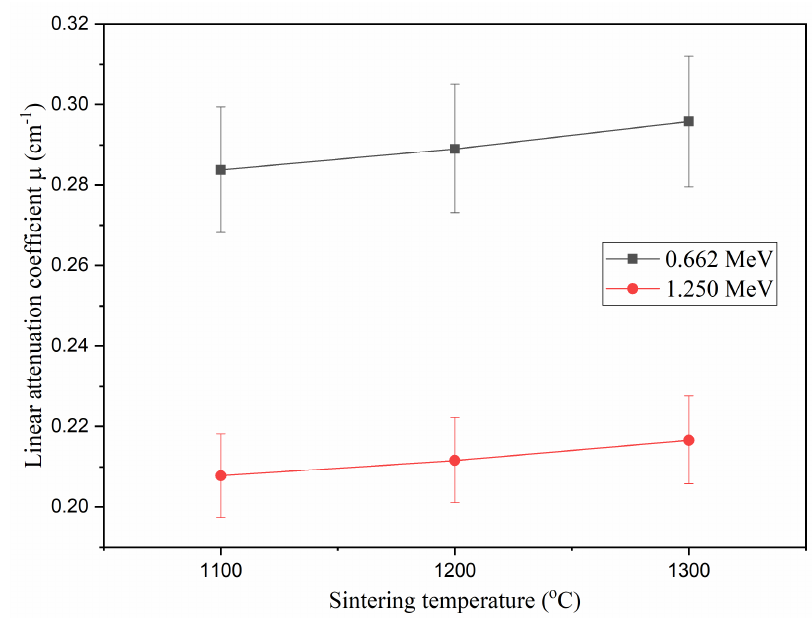
Figure 4. Dependence of the µ values on the